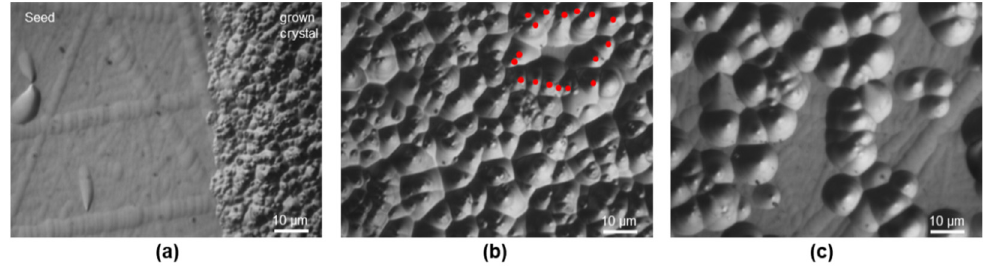
Figure 4. Microscopic images of the KOH etched wafer taken from crystal B: ( a ) interface between seed and grown crystal; ( b , c ) images taken further to the right of the interface inside the area of the grown crystal. A dislocation network is marked in ( b ).